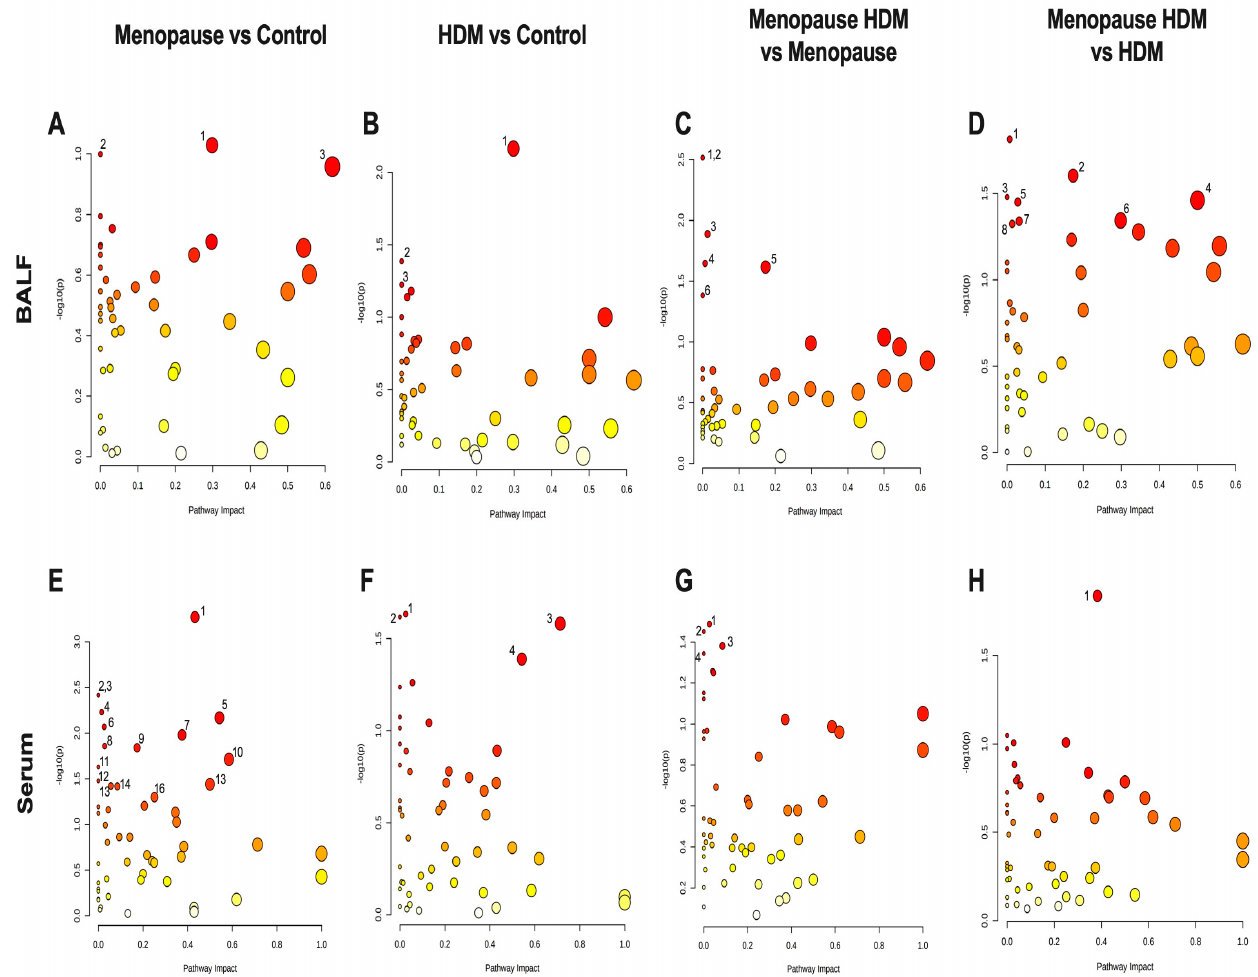
Figure 3. Pathway analysis plots for group comparison in BALF ( A – D ) and serum ( E , F ). ( A , E ) Menopause vs Control; ( B , F ) HDM vs Control, ( C , G ) Menopause HDM vs Menopause; ( D , H ) Menopause HDM vs HDM. The log p -values of the signi fi cantly di ff erent metabolites are plo tt ed within a given metabolic pathway by the impact score that those metabolites have on the pathway. The size of the circle correlates to the number of signi fi cantly di ff erent metabolites detected for that pathway. Numbers next to circles correspond to numbers next to pathways listed in Tables 3 and 4. Table 3. Signi fi cantly impacted metabolic pathways in the BALF.